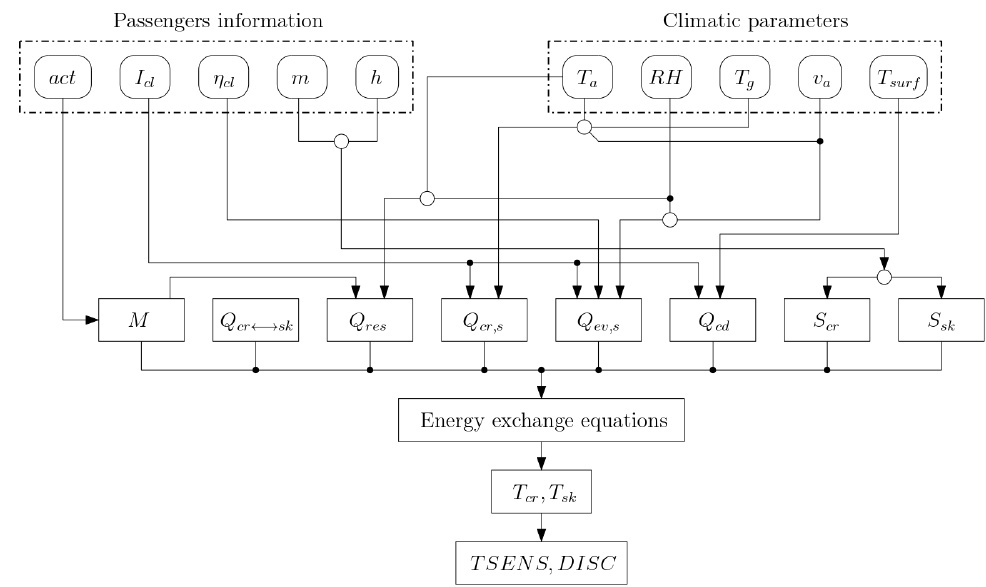
Figure 1. Schematic representation of the employed two-nodes thermal comfort model. Table 3. Passenger parameters for the employed two-nodes thermal comfort model. Parameter Definition Unit Clothes vapor permeation η cl - efficiency act Activity grade